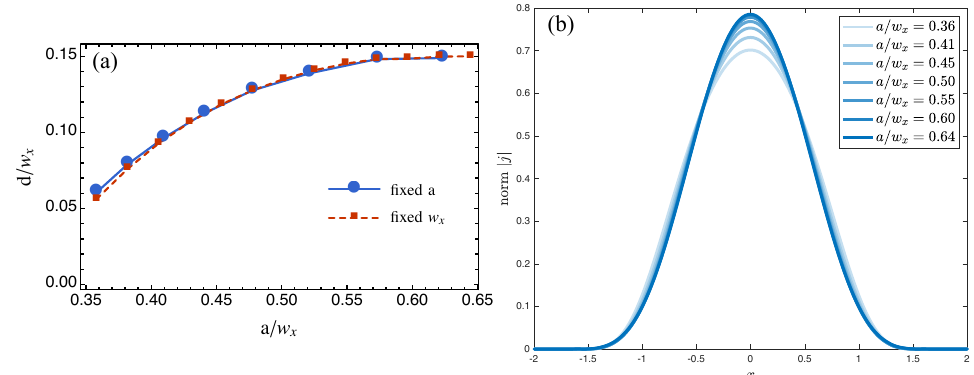
Figure 6: Numerical test of the heuristic argument for the sinusoidal current profile ( x ) with quantum critical conductivity σ ( k ) = exp ( − ak ) . (a): the best fitting J y distance d (D4) versus the exponent a and the width w . We obtain the blue curve x = 3 µ m. Upon by a fixed exponent a = 1.43 µ m, the red curve by a fixed width w x rescaling 1 / w (for blue) as well as a (for red) to a / w , we find that the curves x x (cid:174) 0.5, d increases with respect to a / w coincide. In the transient regime a / w . x x (cid:166) 0.5, however, they saturate to d ≈ w / 7, indicating a non-changing When a / w x x profile. This is supported by plot (b), which demonstrates that the current profiles (cid:166) 0.5: the spatial profiles plotted here correspond to data taken collapse once a / w x at every other square (red) plot point in